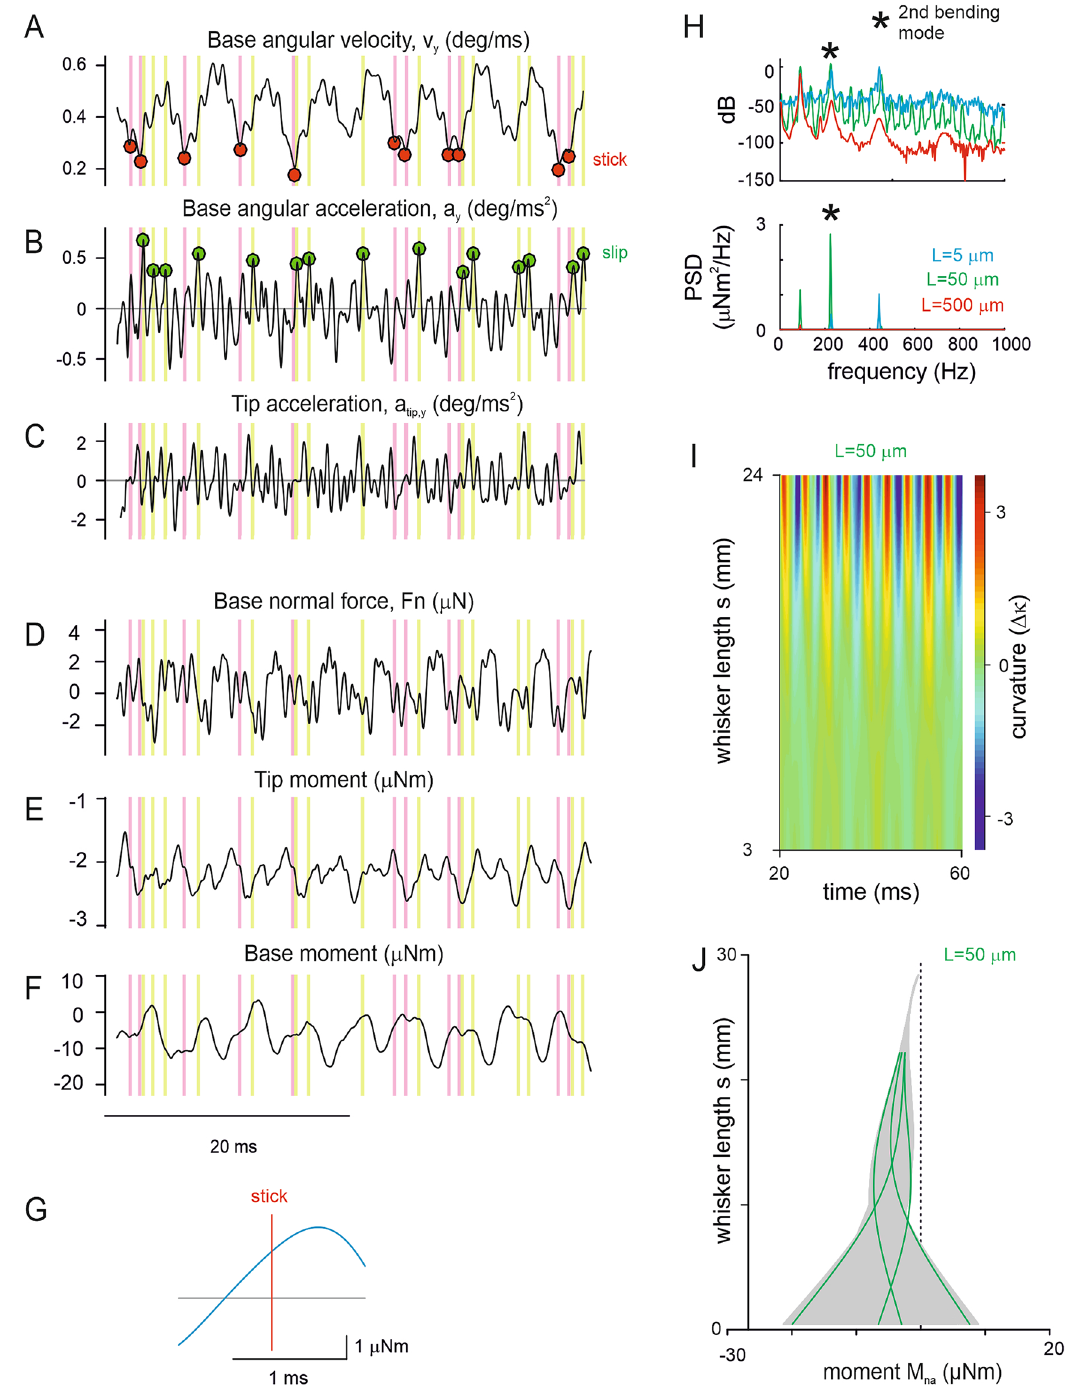
Figure 5. Kinematic and dynamical output variables of the model (see full set of output variables in Table 2). Stick and slip events were identified as in the videographic measurements (cf. Fig. 1E, dots in base kinematic traces in which the identification was done, and lines throughout, red: sticks; green: slips) ( A – C ) Kinematic variables ( D – F ) Dynamical variables. ( G ) The average normal force to the whisker base builds up to a maximum around a stick event. ( H ) Spectra of moments for model runs using different values of L [5,50,500]. Top and bottom are the same data plotted as dB or PSD. Medium values of L match the experimental data (cf. Fig. 2D) best, as this model best recreates the dominance of the 2nd bending mode (2nd harmonic is marked by an 50 μm. (experimental data cf. Fig. 2B). ( J ) Moments asterisk). ( I ) Curvature output ( �κ ) of the model using L = M na ( s , t ) (each line represents moments at one time point along s ). A few lines have been coloured green to demonstrate the node of vibration at 2nd bending mode. Comparable experimental data are in Fig.